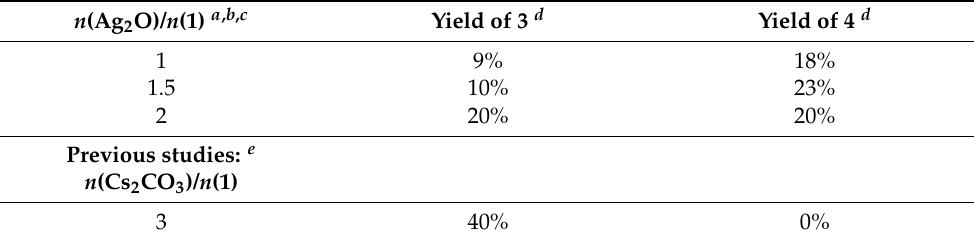
Table 1. Optimization of silver-oxide loading for microwave reaction